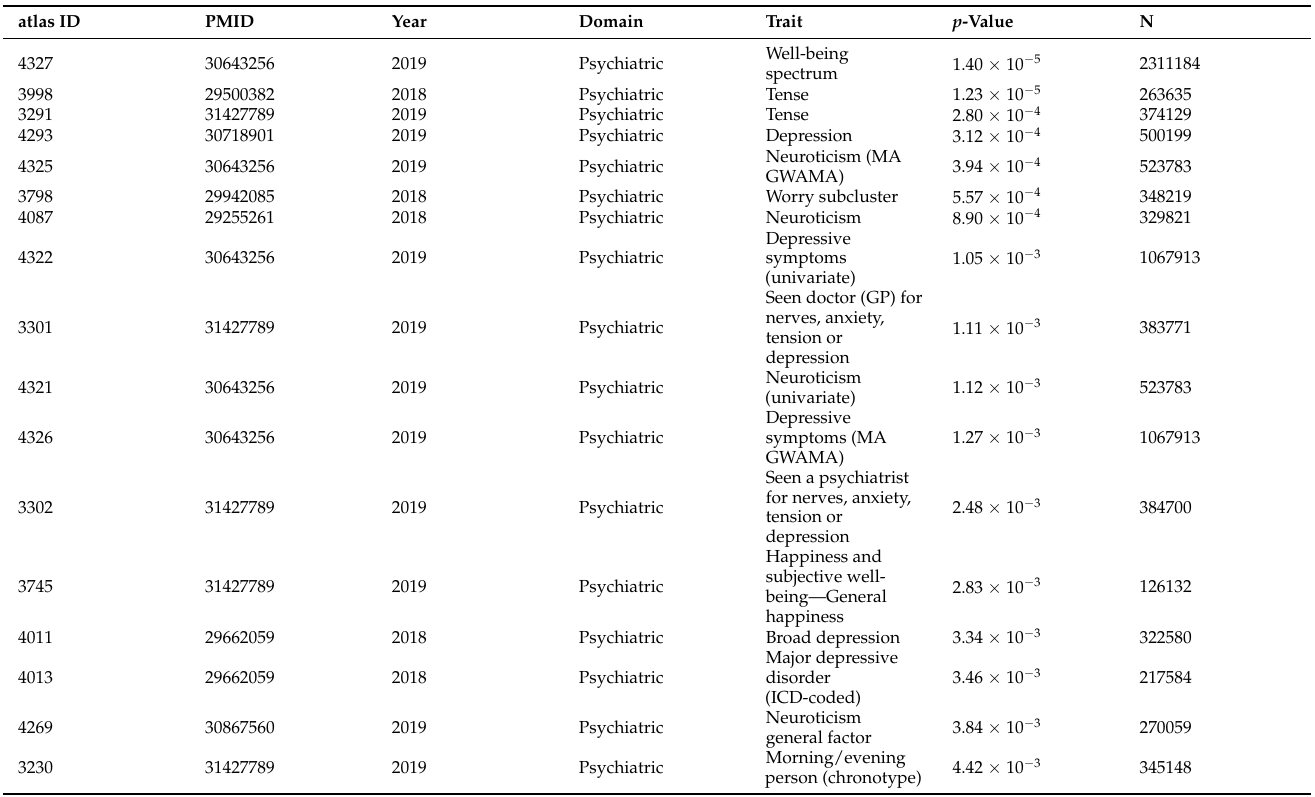
Figure 8. Combining PheWAS hits in GWAS atlases with BXD data allow for more robust screening of variants that affect phenotypes. The QTL at Chr 5 peaks at 99.801–101.331 Mb and contains the genes Hnrnpd and Lin54, which show the highest number of relevant pheWAS hits. Lin54 is listed by trait above and has been previously associated with psychiatric phenotypes.